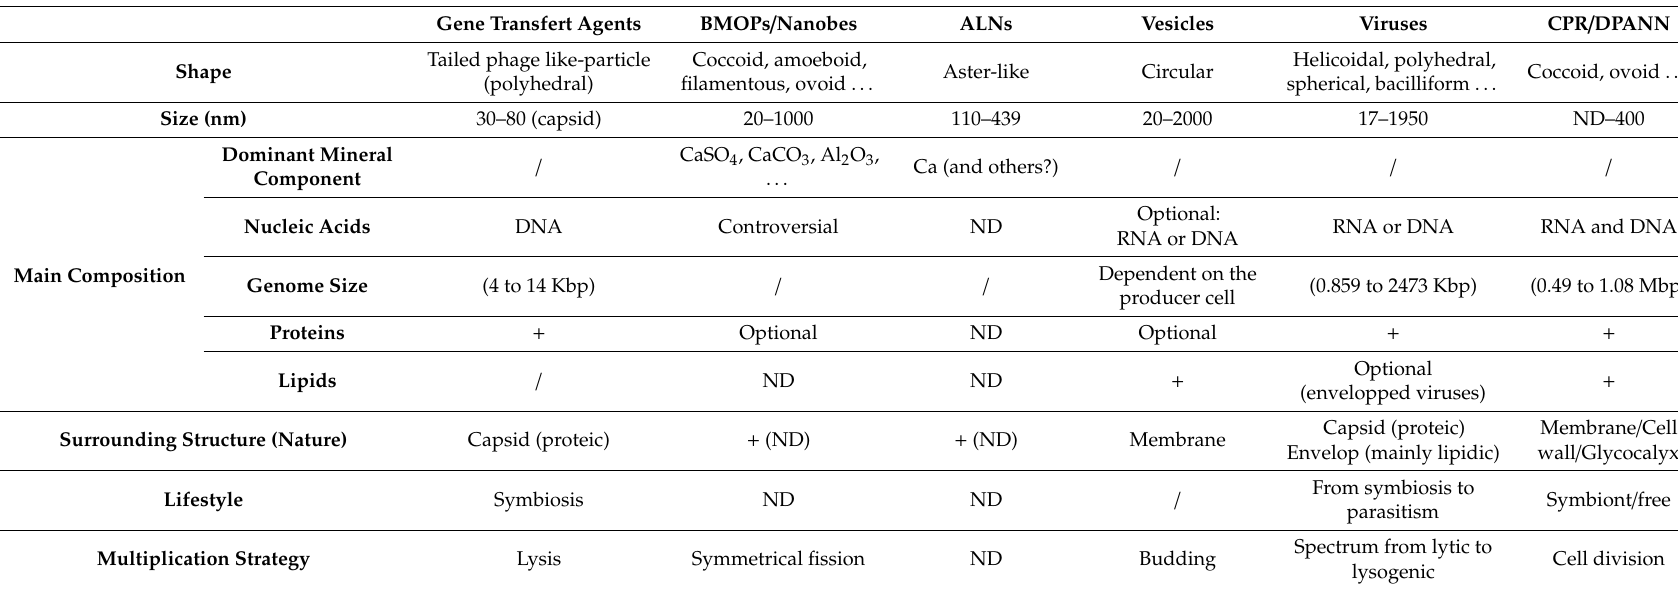
Table 1. Comparison of morphologies, some main constitutional elements and development strategies of femtoplankton